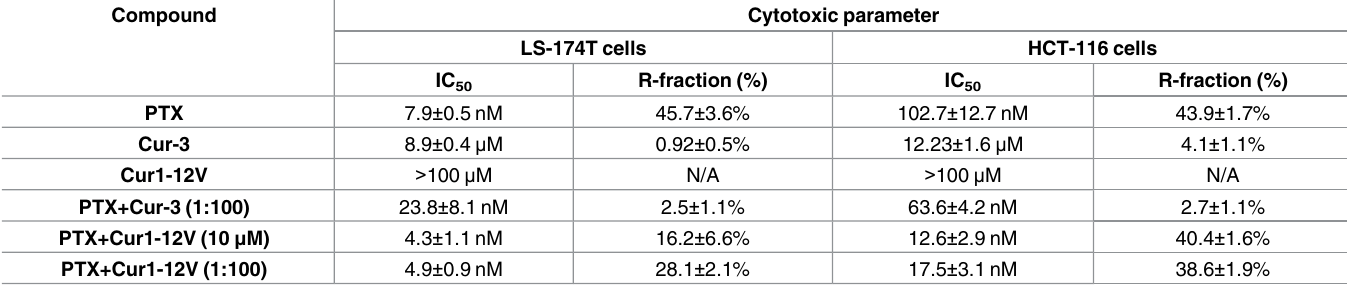
Table 3. Chemomedulatory effects of test compounds on the cytotoxicity parameters of PTX against LS-174T cell line.